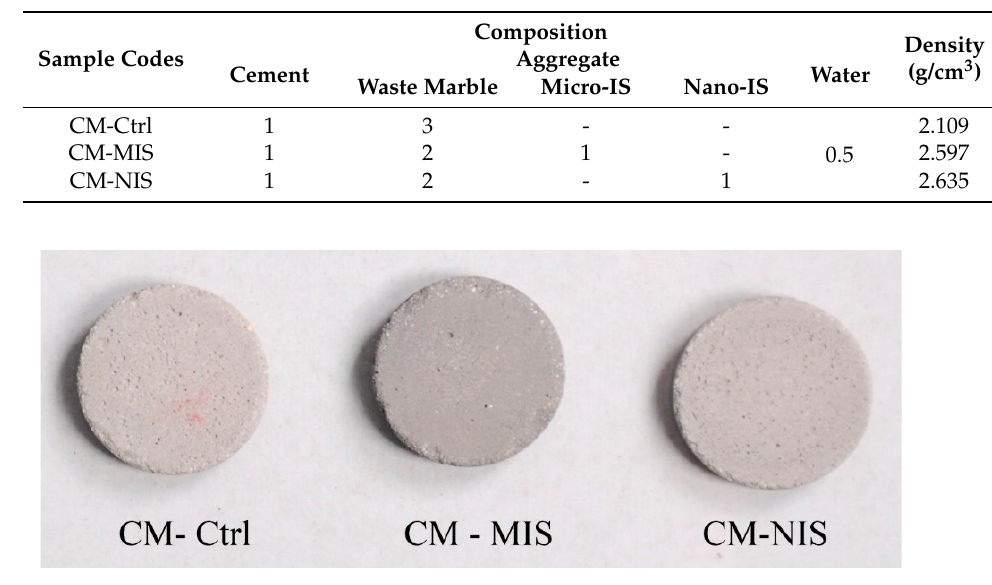
Figure 3. The prepared mortar samples.